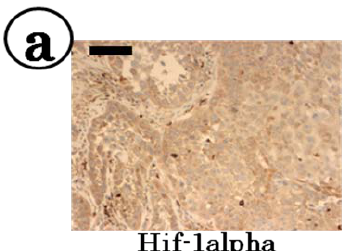
Figure 5. Immunohistochemistry for ( a ) Hif-1 α and ( b ) Nf- κ B in the tongue SCCs in the female KAD rats. Positive scores for ( c ) Hif-1 α and ( d ) Nf- κ B represent the mean ± SD. Inflammation scores for the tongue in the KAD and F344/NS1c rats. ( a ) and ( b ) are representative photos of tongue SCCs with inflammation in a male KAD and female KAD rat, respectively. ( c ) The values of the inflammation score represent the mean ±